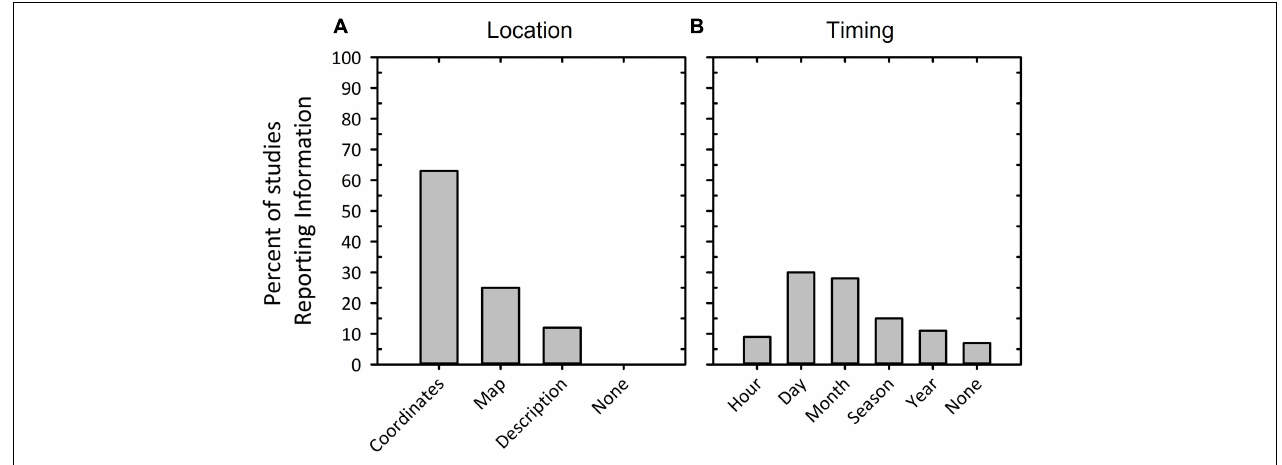
FIGURE 1 | Plots showing the level of precision to which authors reported (A) the location of burn and (B) the timing of burn in recent prescribed fire